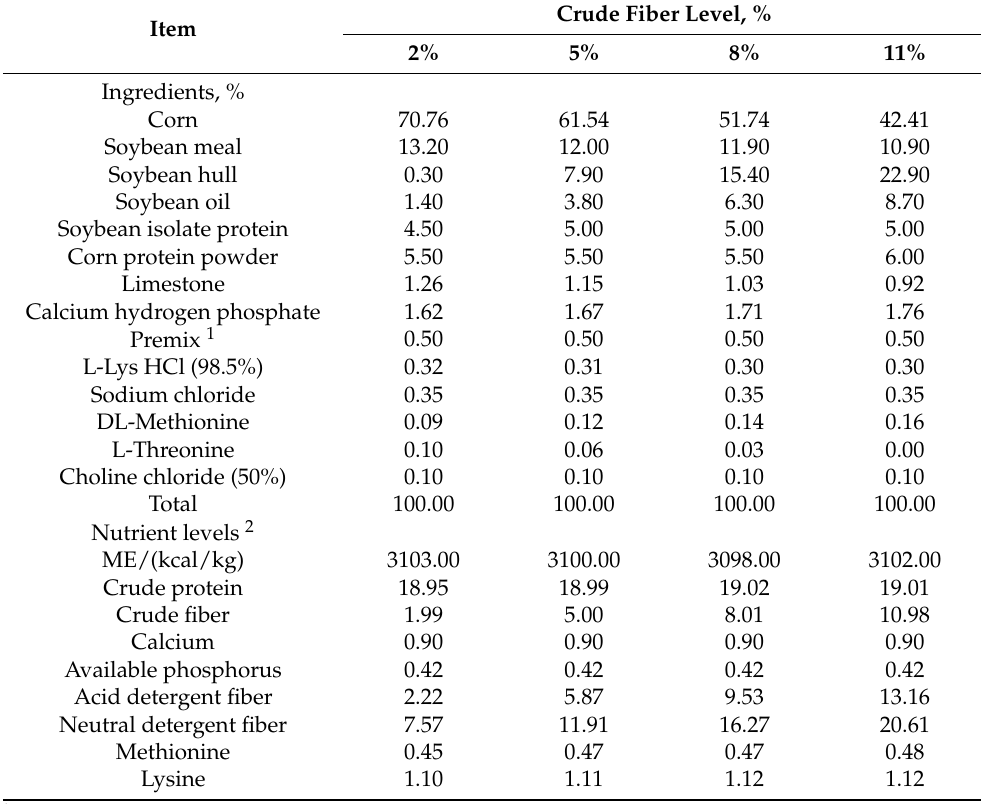
Table 1. Ingredient composition and nutrient levels of experimental diets from day 22 to 43 (dry matter